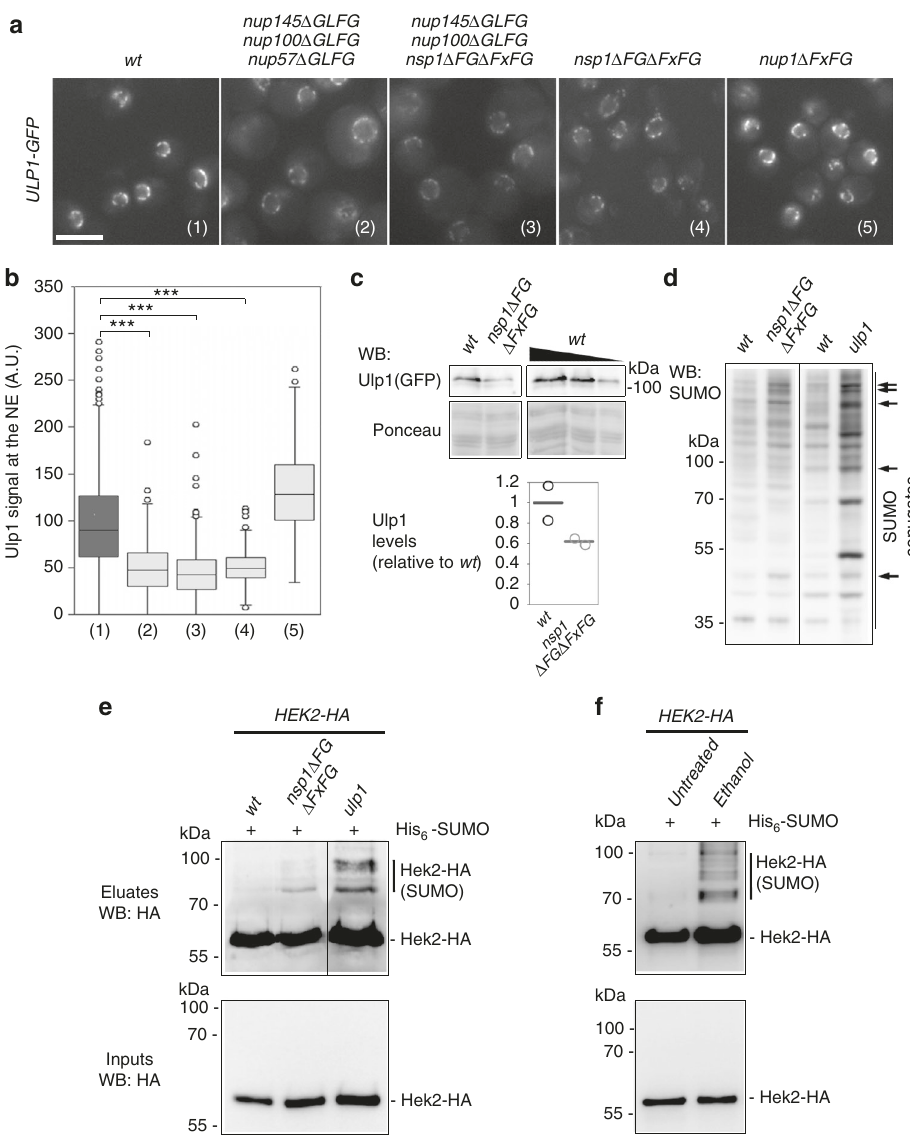
Fig. 4 Defects in nuclear pore integrity impact Ulp1 activity and Hek2 sumoylation. a Fluorescence microscopy analysis of Ulp1-GFP in wt , nup145 Δ GLFG nup100 Δ GLFG nup57 Δ GLFG , nup145 Δ GLFG nup100 Δ GLFG nsp1 Δ FG Δ FxFG , nsp1 Δ FG·FxFG and nup1 Δ FxFG cells grown at 30 ° C. Scale bar, 5 µ m. b Quanti fi cation of the Ulp1 nuclear envelope fl uorescence intensity in the different strains. The numbers refer to the genotypes as depicted in ( a ). For each strain, at least 150 cells were analyzed. Boxplots were generated using KaleidaGraph (Synergy Software): each box encloses 50% of the measured values, the median is displayed as a line, and the bars extending from the top and bottom of each box mark the minimum and maximum values within the dataset falling within an acceptable range. Values falling outside of this range are displayed as individual points. *** P < 0.001 (Mann – Whitney – Wilcoxon test). c Ulp1-GFP amounts were measured in wt and nsp1 Δ FG Δ FxFG cells by western blotting using anti-GFP antibodies (top panel). Ponceau staining was used as a loading control (lower panel). A serial dilution of the wt sample was used for quanti fi cation. Ulp1-GFP amounts normalized to ponceau are represented (mean and individual points, n = 2). d Whole cell extracts of the indicated strains were analyzed by western blotting using anti-SUMO antibodies. The bands that are modi fi ed in the nsp1 Δ FG Δ FxFG mutant are also typically altered in ulp1 cells (arrows). e Hek2 sumoylation was detected in wt and nsp1 Δ FG Δ FxFG cells as in Fig. 3. Total lysates ( “ Inputs ” ) and puri fi ed His-SUMO conjugates ( “ Eluates ” ) were analyzed by western blotting using anti-HA antibodies. The pattern of Hek2 sumoylation in ulp1 cells was analyzed as a control. The positions of the sumoylated and unmodi fi ed versions of Hek2-HA, as well as molecular weights, are indicated. f Hek2 sumoylation was similarly detected in wt cells, either untreated, or treated with 10% ethanol for 1